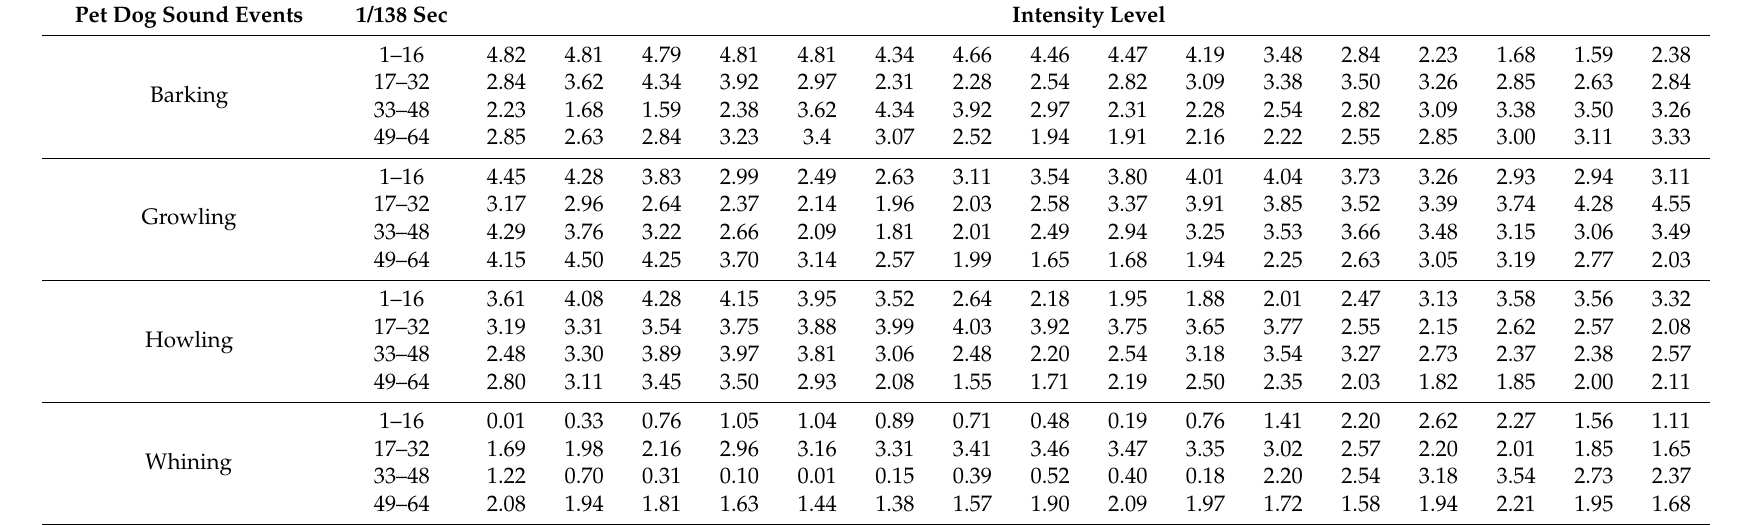
Table 5. An example of intensity data for pet dog sound event obtained from noise